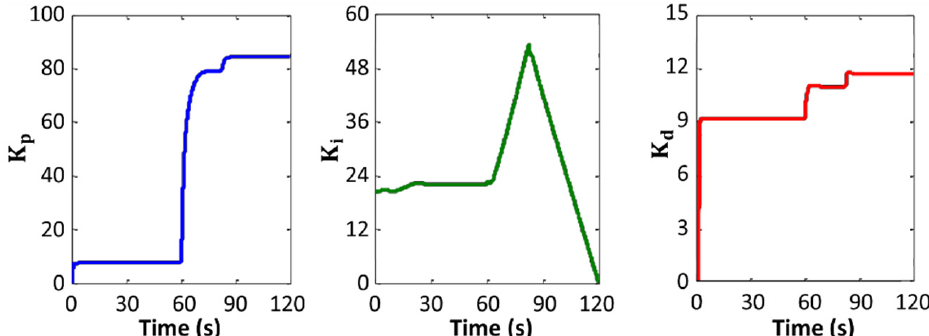
Figure 13. Variations in adaptive gain values of the X position PID controller.